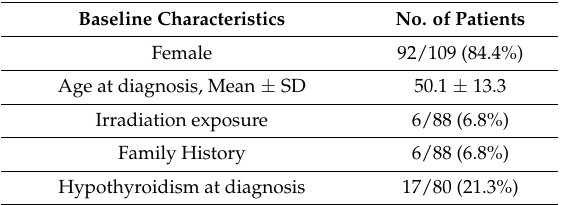
Table 1. Baseline characteristics and disease outcome in 109 papillary thyroid cancer (PTC) patients treated with